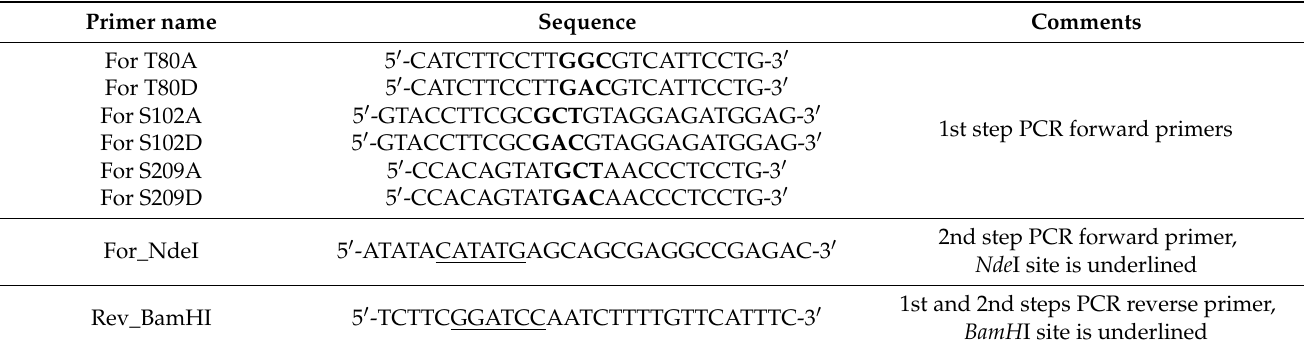
Table 1. List of primers. The nucleotides introducing corresponding mutations are in bold; the sites of restriction endonucleases are